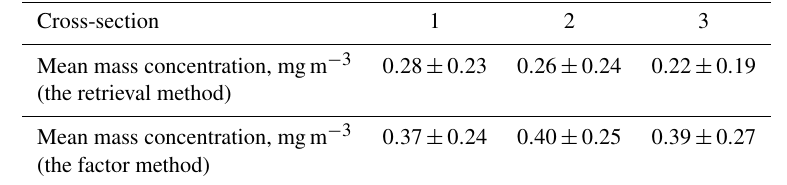
Table 1. Mean dust mass concentration of each cross-sections on 19 June 2020 calculated by two methods.